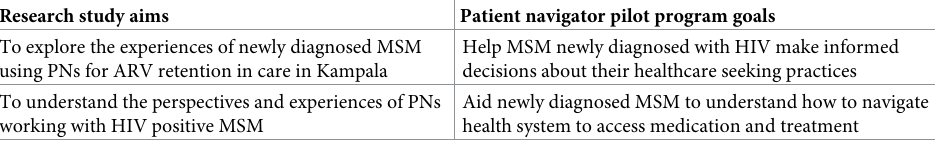
Table 1. Summary of research study aims and patient navigator pilot program